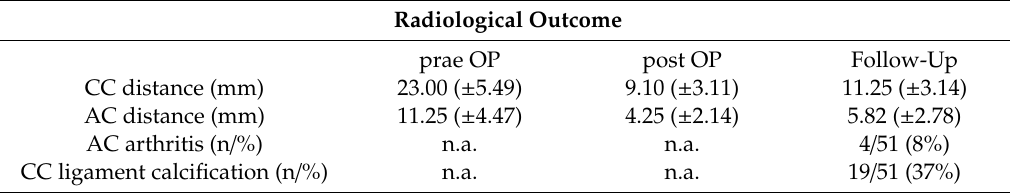
Table 3. Radiological outcome. Coracoclavicular (CC) and Acromioclavicular (AC) distances are displayed in millimeters (mm). Not available (n.a.). The values are given as arithmetic mean and standard